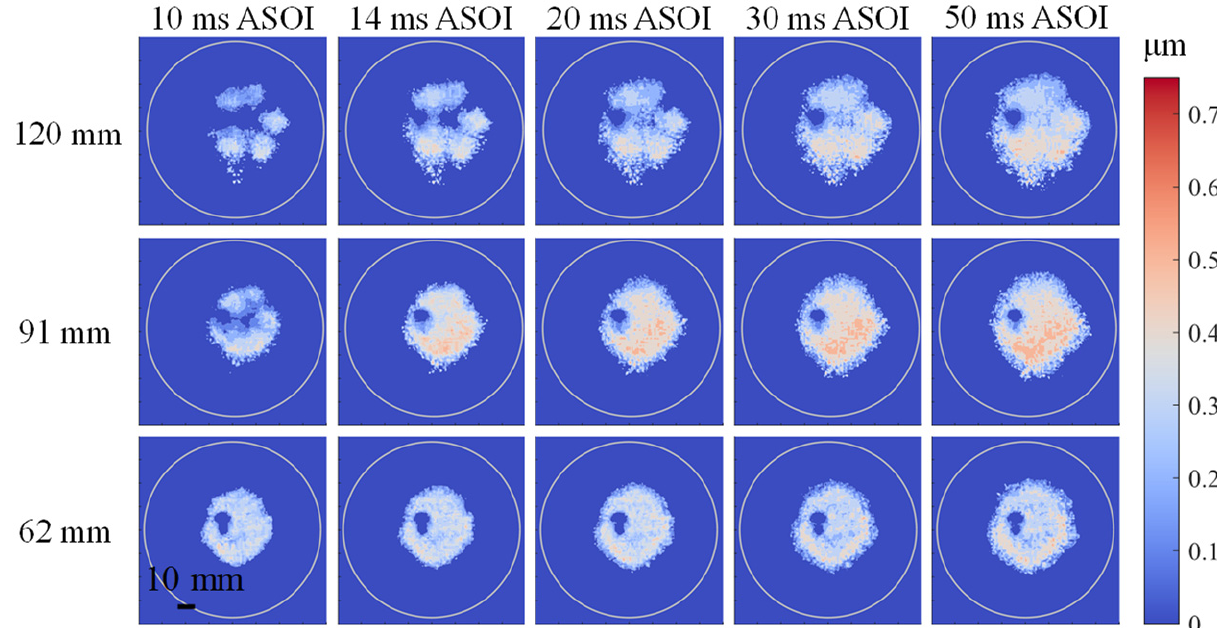
Figure 12. ( a ) Impinging spray height H i and ( b ) width W i of impinging spray under different P inj .